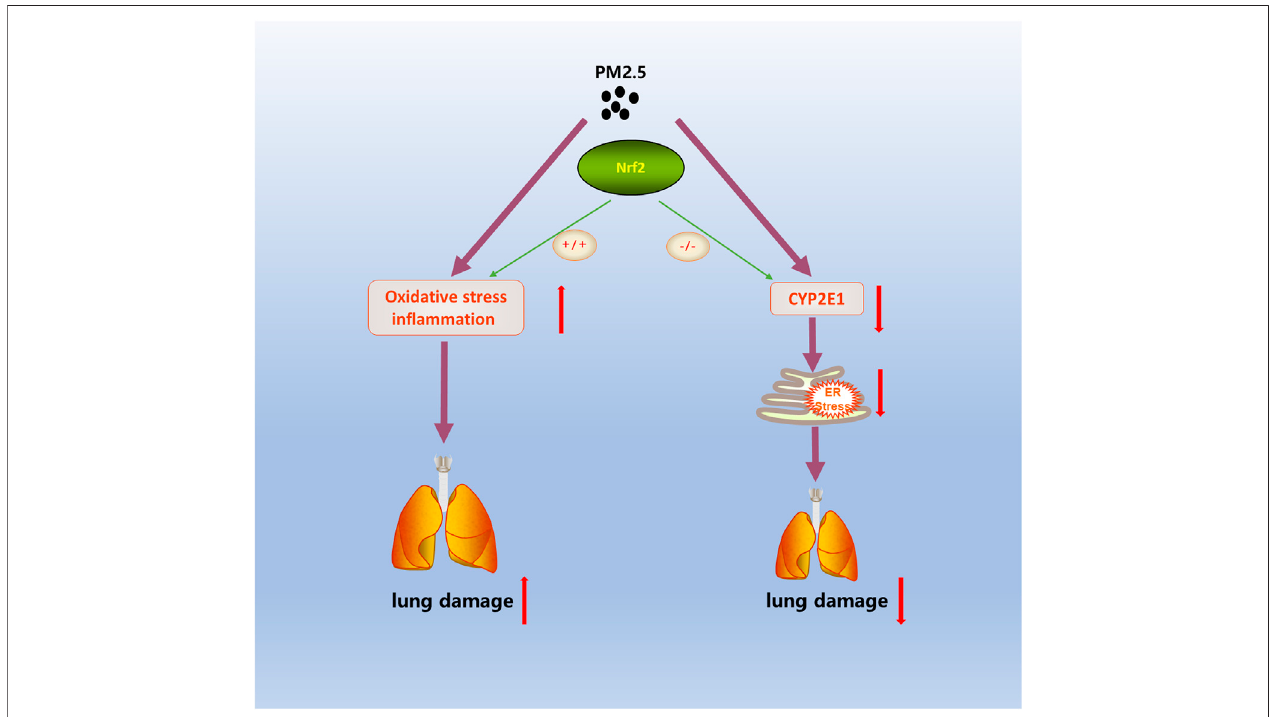
FIGURE 6 | Scheme of the Nrf2-mediated lung injury induced by PM 2.5